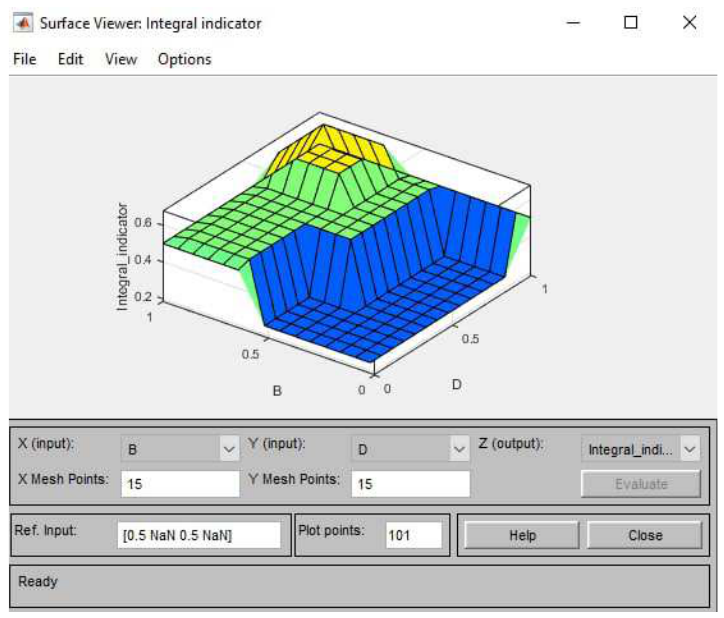
Figure 6. Assessment model of the logistic service quality